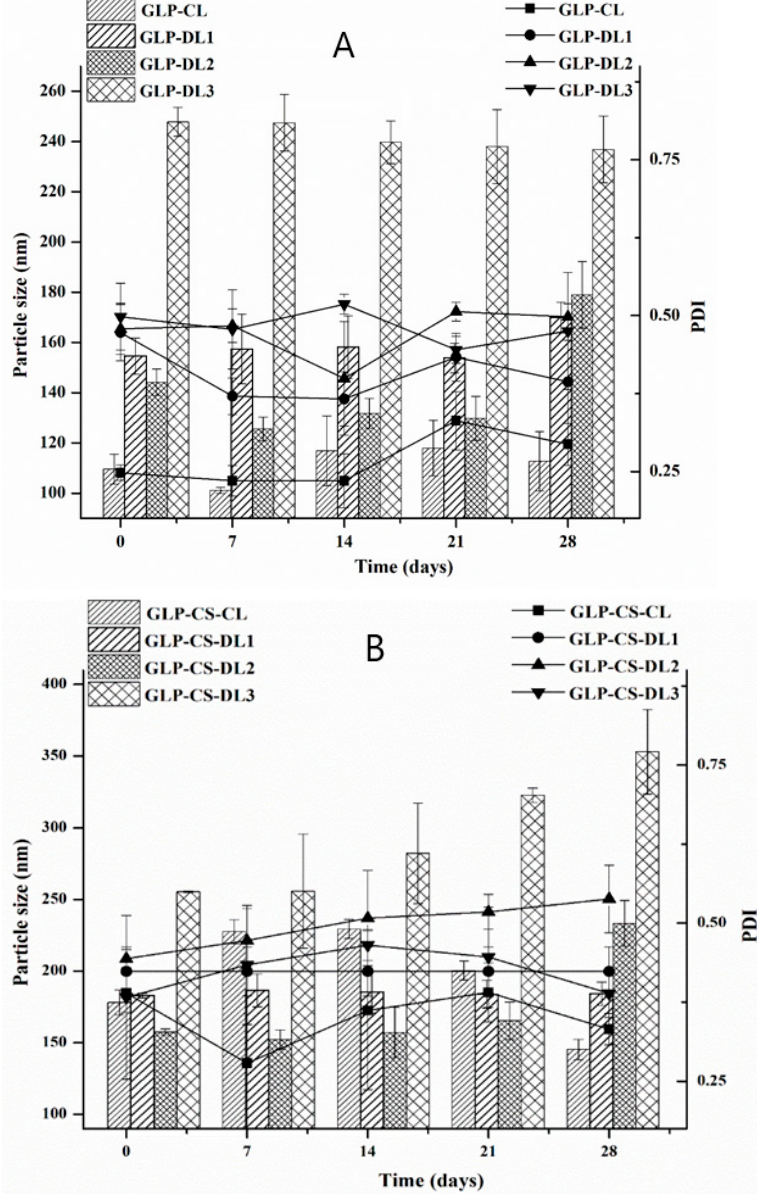
Figure 3. Stability of GLP-loaded CL-, DL- ( A ), and CS-coated CL/ DL ( B ); particle size and PDI ( n = 3, mean ± SD). 3.4. Evaluation of GLP-Loaded Liposome- and CS-Coated Liposomes-Based Transdermal Films Thus the obtained film was formulated with GLP-loaded coated and uncoated lip- osomes with two goals, the controlled transdermal delivery and the highest percutane- ous of GLP. In consideration of the treatment of hyperglycemia, GLP-loaded film should be of fixed dimensions with content uniformity to give sustained release. The results found that physicochemical characteristics, such as thickness, weight variation, moisture uptake, drug content, and folding endurance, exhibited a slight variation among the ob- tained films. These parameters evaluated for films are listed in Table 4. The prepared films were smooth in appearance and uniform, without visible cracks. The thicknesses of all films varied from 0.157 ± 0.021 to 0.250 ± 0.017 mm. As shown in Table 4, the weight variation was in the range of 30.96 ± 6.14 to 55.14 ± 3.29 mg. The films produced were found to be satisfactory in terms of their weight variation. The percentage moisture up- take of the tested transdermal films ranged from 5.32 ± 0.69 to 16.81 ± 3.21. The prepared transdermal films showed low percentages of moisture uptake, which are important to ensure the stability of the films and protect them from microbial contamination and bulkiness [30]. As shown in Table 4, the moisture uptake was higher in transdermal films containing chitosan, as it is hydrophilic; a previous study also achieved this result [42]. The folding endurance was found to be <100 with GLP-CL-TDF, GLP-CS-CL-TDF, GLP-DL2-TDF, and GLP-CS-DL2-TDF, which indicated lower strength. However, GLP-DL1-TDF and GLP-DL3-TDF and their CS coating showed a >100 folding endur- ance, ensuring their acceptable strength, elasticity, and integrity with general skin folding after application. This performance may be attributed to the presence of Tween 80 in GLP-DL1-TDF and GLP-DL3-TDF and their CS coating, which produced a high de- formability with a lower DI according to the deformability study. These findings are in agreement with other obtained observations [46]. Uniform drug content was reported for the prepared transdermal films ranging from 97.54 ± 1.89% to 107.40 ± 1.55%. This shows